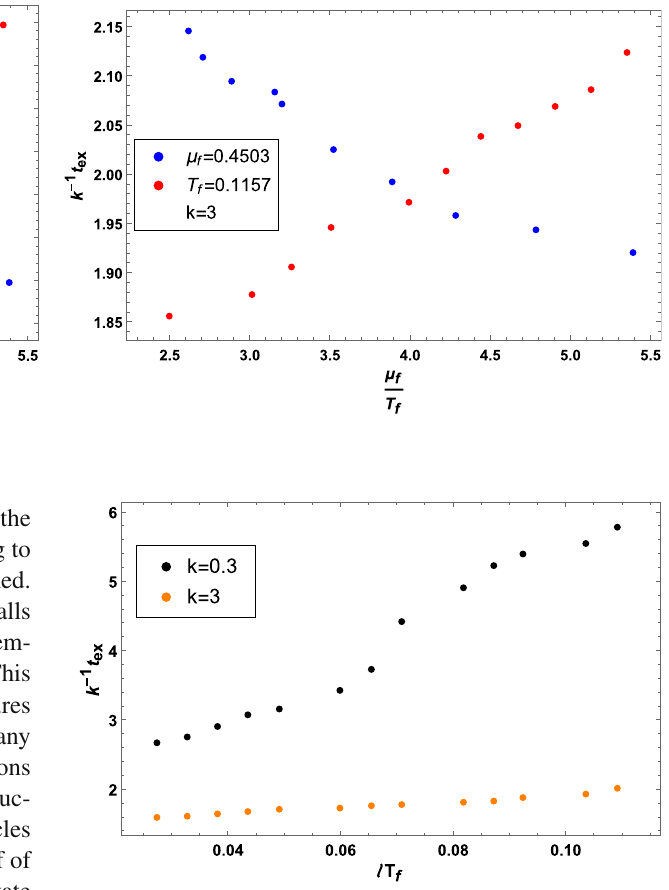
Fig. 6 The excitation time in terms of lT f for T f = 0 . 1091 and μ f = 0 .